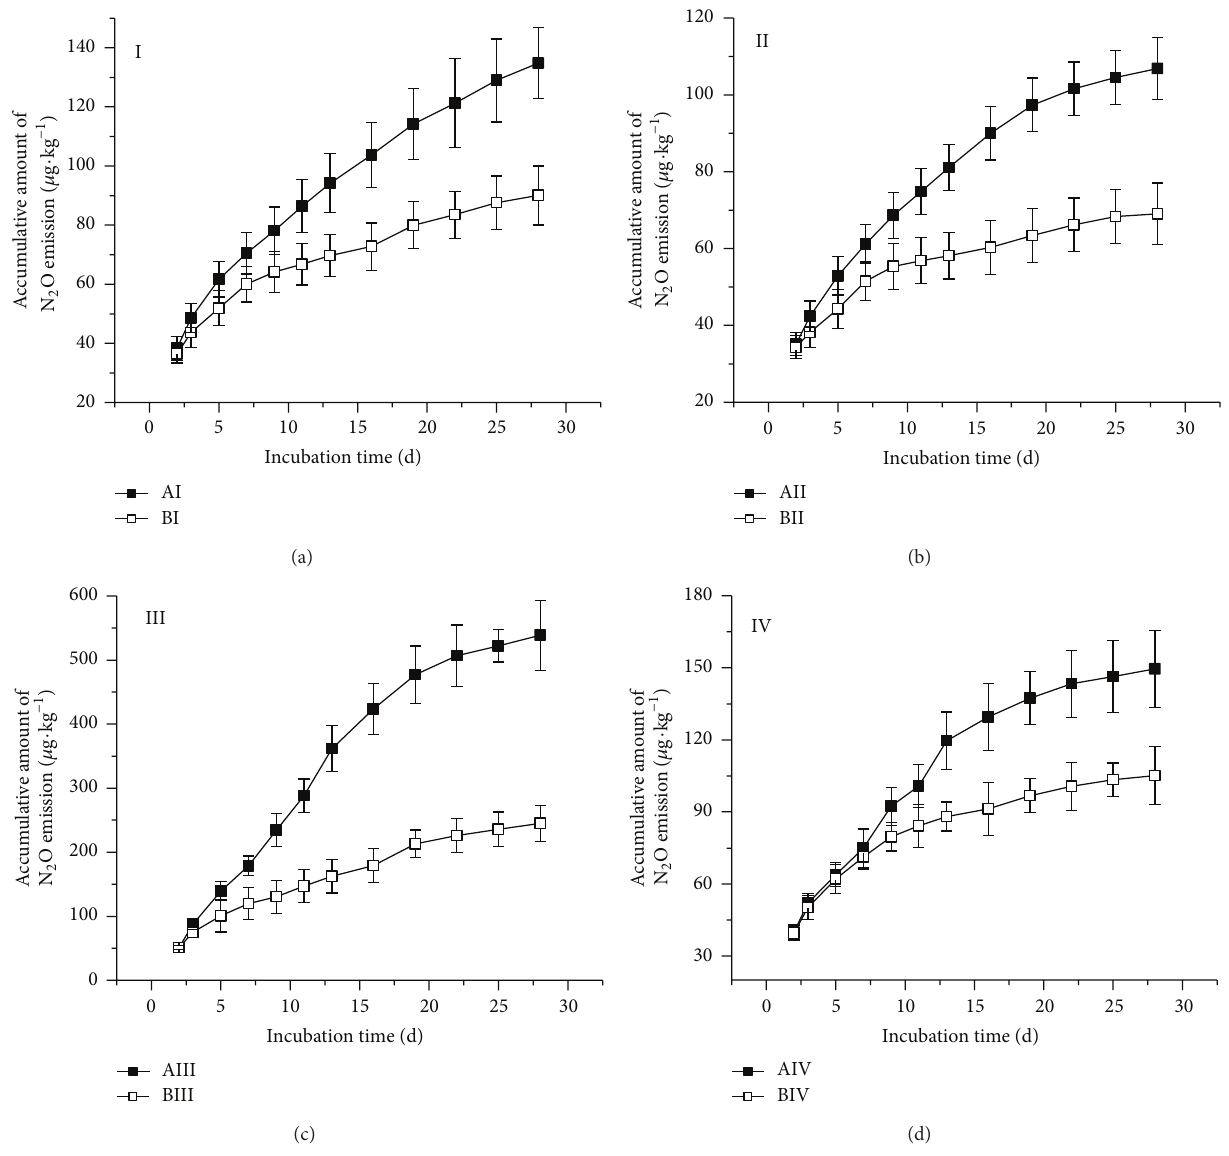
Figure 2: Cumulative amount of N 2 O emission of the treatments studied. (Treatments notations are as follows: A: incubation at 35 ∘ C; B: incubation at 20 ∘ C; I: peat soil; II: peat soil under flooding; III: peat soil plus raw organic matter; IV: peat soil under flooding plus organic